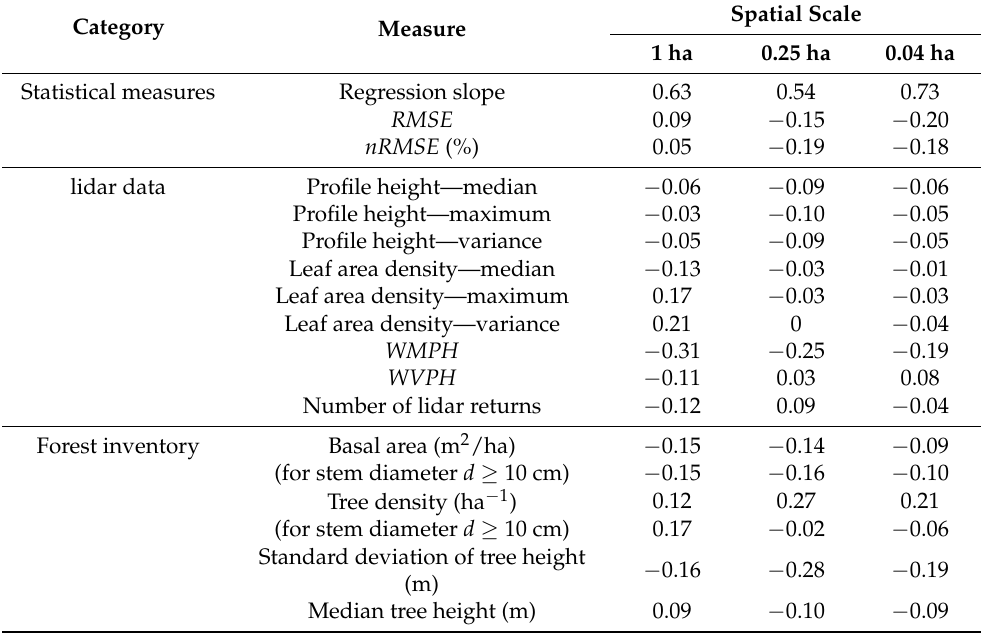
Table A3. Correlation coefficients (Spearman’s r ) of R 2 values (of the compared lidar-derived and inventoried stem diameter distribution) correlated with other statistical measures, lidar data measures, and forest structure attributes for different plot sizes (1, 0.25, and 0.04 ha). See methods and Table 1 for